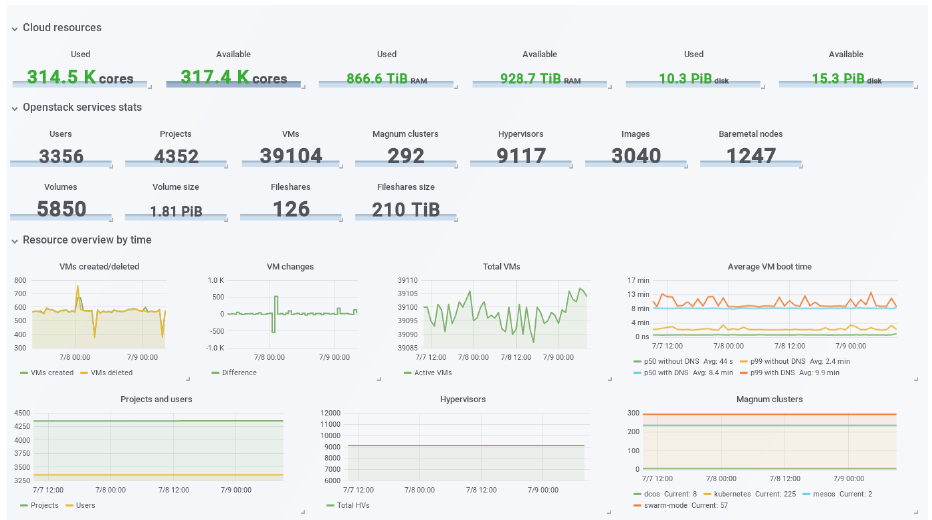
Figure 1. Current resource status of the CERN Cloud Infrastructure Service